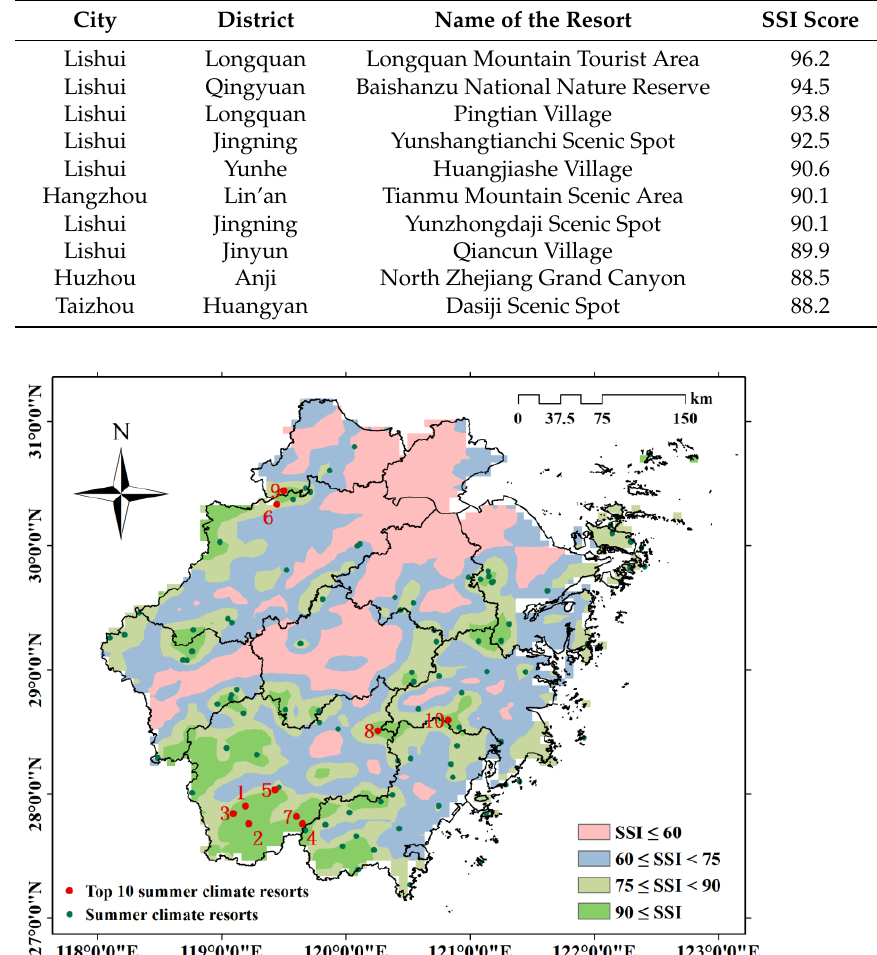
Figure 4. Distribution of SSI in Zhejiang Province. Green dots are the summer climate resorts, red dots are the top 10 summer climate resorts and red number is the rank corresponding to Table 3. Table 3. Top 10 summer climate resorts in Zhejiang Province.